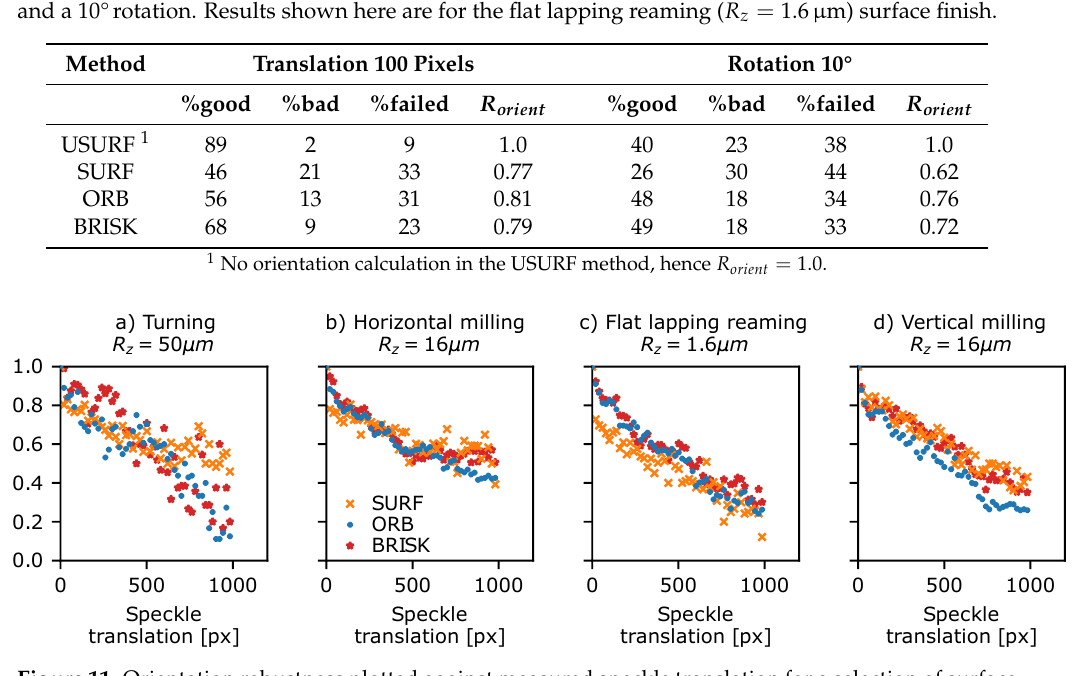
Figure 11. Orientation robustness plotted against measured speckle translation for a selection of surface treatments shown in Figure 1. ( a ) Turning R z = 50 µ m, ( b ) horizontal milling R z = 16 µ m, ( c ) flat lapping reaming R z = 1.6 µ m, and ( d ) vertical milling R z = 16 µ